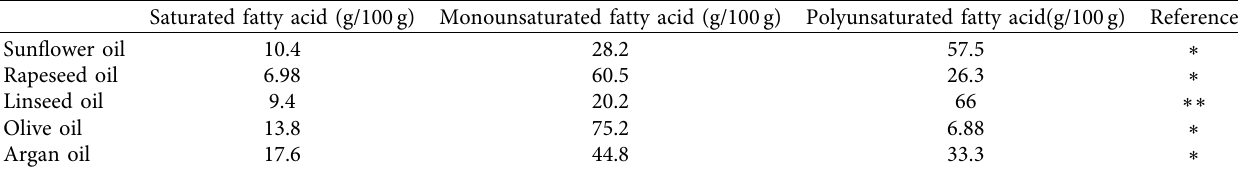
Table 1: Chemical composition of different vegetable oils.